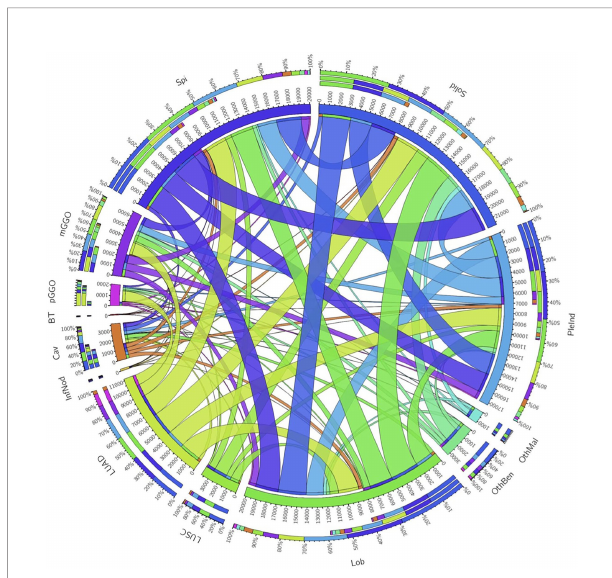
FIGURE 2 | Circos of the correlation of pathological subtypes and morphological features. Outermost circle denoted the total number of corresponding relationships, the middle and innermost circle denoted the relationship. The wider the strip, the stronger the correlation. Spi, Spiculation; Lob, Lobulation; PleInd, Pleural Indentation; Cav, Cavity; pGGO, pure ground glass opacity; mGGO, mixed ground glass opacity; BT, Benign Tumors; InfNod, In fl ammatory Nodule; OthBen, Other Benign Lesions; LUAD, Adenocarcinoma; LUSC, Squamous Carcinoma; OthMal, Other Malignant